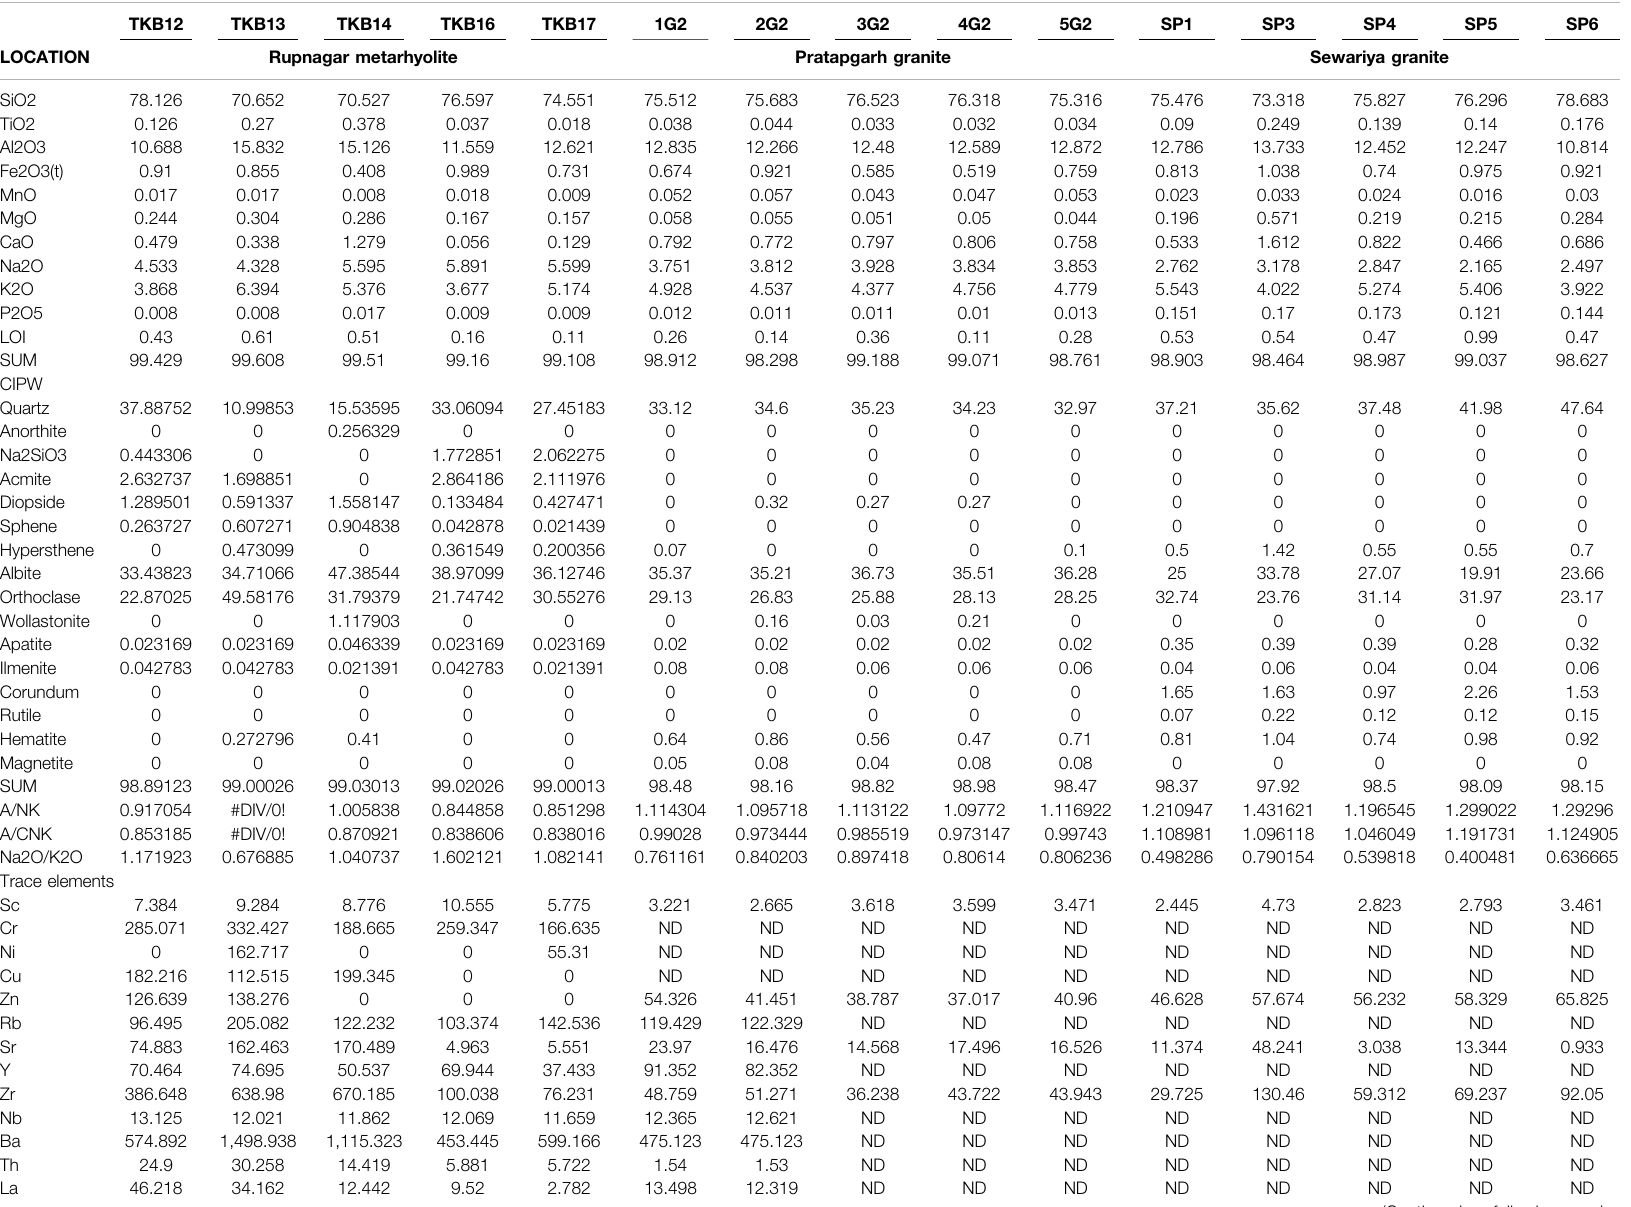
TABLE 2 | Major element geochemistry of the granites. Few samples have been analyzed for trace elements. LOI is negligible ( <